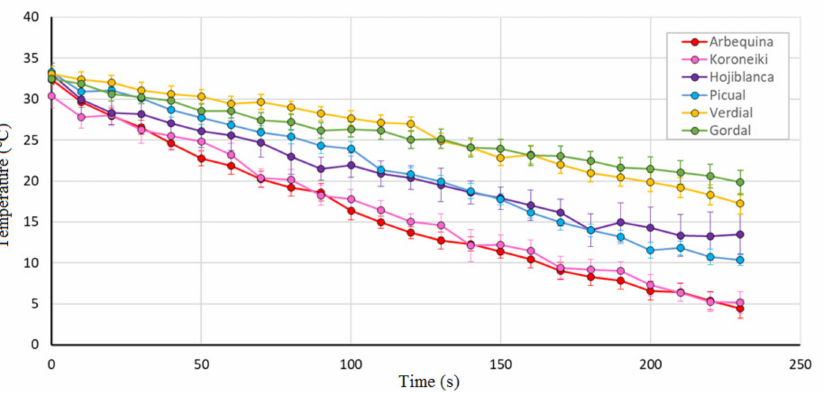
Figure 2. Evolution of the fruit temperature of 6 samples of olive fruit ( n = 25) placed in a freezing chamber at − 17 ◦ C ( ± 1 ◦ C). Vertical bars represent ± 1 SD of the mean values.